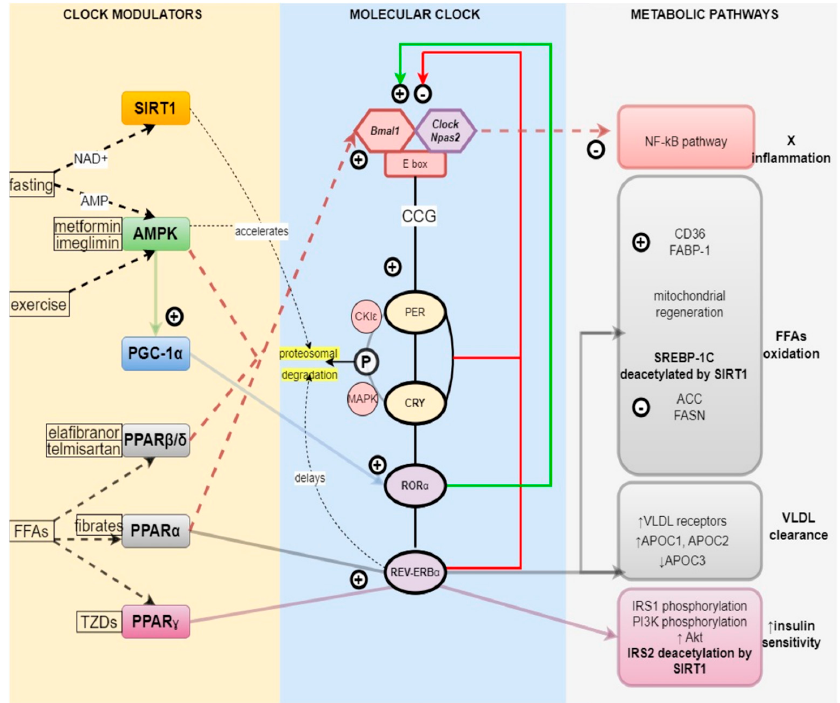
Figure 1. Relationship between molecular clock and metabolism. SIRT1 senses nutrient deprivation through elevated NAD+ levels and accelerates PER degradation in proteosomes, phase − advancing the molecular clock. SIRT1 also deacetylates SREBP − 1C and IRS2, increasing FFA oxidation and insulin sensitivity, respectively. AMPK is upregulated by fasting through high AMP levels, exercise, and medications such as metformin and imeglimin. AMPK accelerates CRY degradation, resetting the molecular clock. It downregulates the NF − kB pathway, thereby reducing inflammation. It also promotes PGC − 1 α expression, which, through the ROR α clock component, stimulates mitochondrial regeneration and FFA oxidation. PPAR β / δ and PPAR α inhibit the NF − kB pathway and reduce inflammation, as well as increase FFA oxidation. PPAR α stimulates REV − ERB α -mediated VLDL clearance. PPAR γ increases insulin sensitivity via REV − ERB α -mediated pathway. Abbreviations: SIRT1, sirtuin1; AMPK, adenosine monophosphate (AMP) activated protein kinase; PGC − 1 α , peroxisome proliferator − activated receptor − gamma coactivator 1 α ; NAD+, nicotinamide adenine dinucleotide; AMP, adenosine monophosphate; PPAR β / δ , proliferator-activated receptor β / δ ; PPAR α , proliferator − activated receptor α ; PPAR γ , peroxisome proliferator − activated receptor γ ; FFA(s), free fatty acid(s); TZDs, thiazolidinediones; Bmal1, basic helix − loop − helix ARNT − like 1; Clock, Circadian Locomotor Output Cycles Protein Kaput; Npas2, neuronal PAS domain protein 2; CCG, clock-controlled genes; PER, period proteins; CRY, cryptochrome proteins, ROR α , retinoic acid-related orphan receptor α ; REV − ERB α , reverse-strand avian erythroblastic leukemia (ERBA) oncogene receptor α ; MAPK, mitogen − activated protein kinase; CK1 ε , casein kinase I isoform epsilon; NF − kB, nuclear factor kappa − light − chain − enhancer of activated B cells; FABP − 1, fatty acid binding protein 1; SREBP − 1C, sterol regulatory element-binding protein 1; ACC, acetyl − CoA carboxylase; FASN, fatty acid synthase; VLDL, very low density lipoprotein; APOC, genes encoding apolipoproteins C; IRS, insulin receptor substrate; PI3K, phosphatidylinositol − 3 − kinases; Akt, protein kinase B.